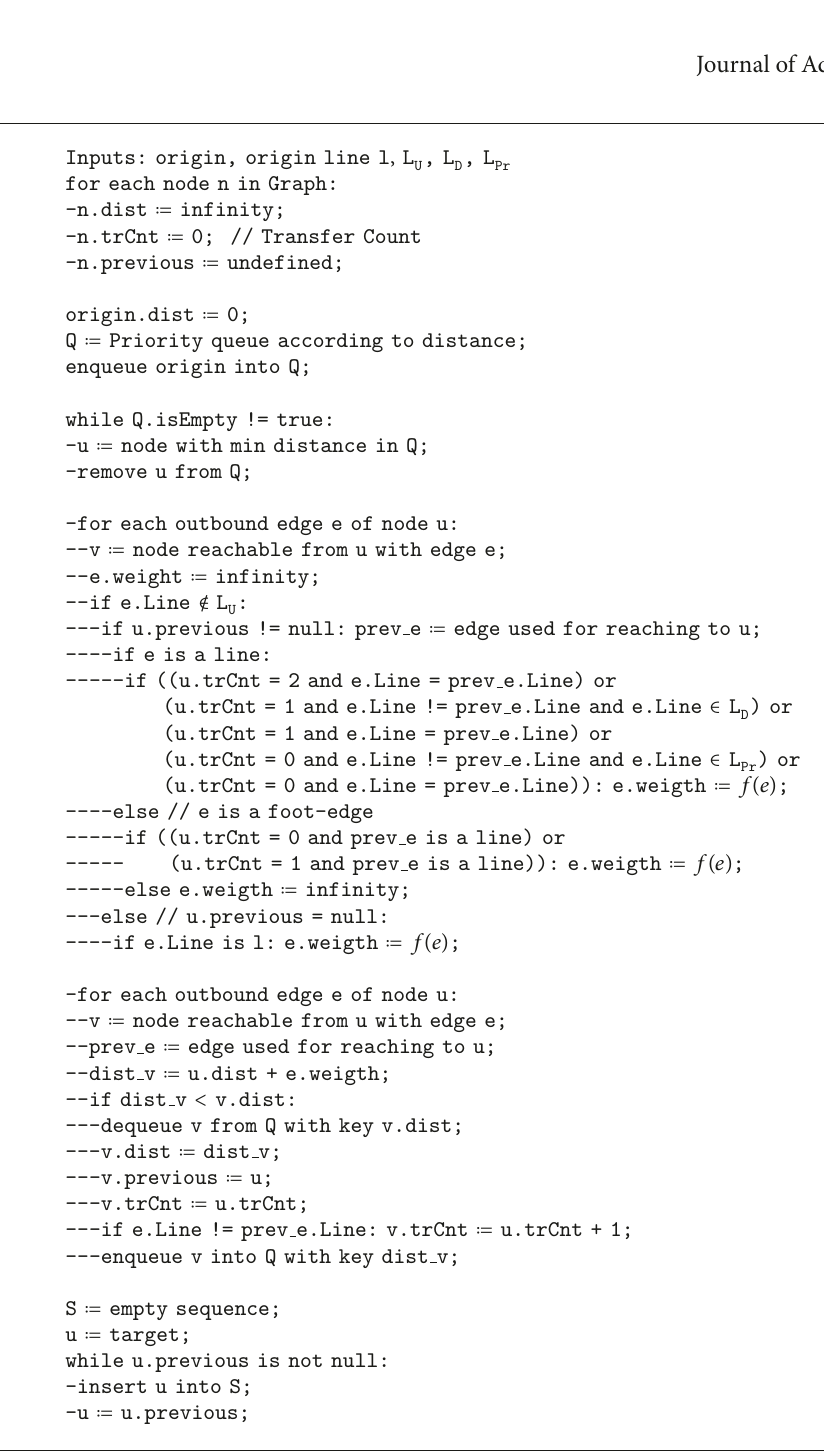
Algorithm 2: Finding routes containing two